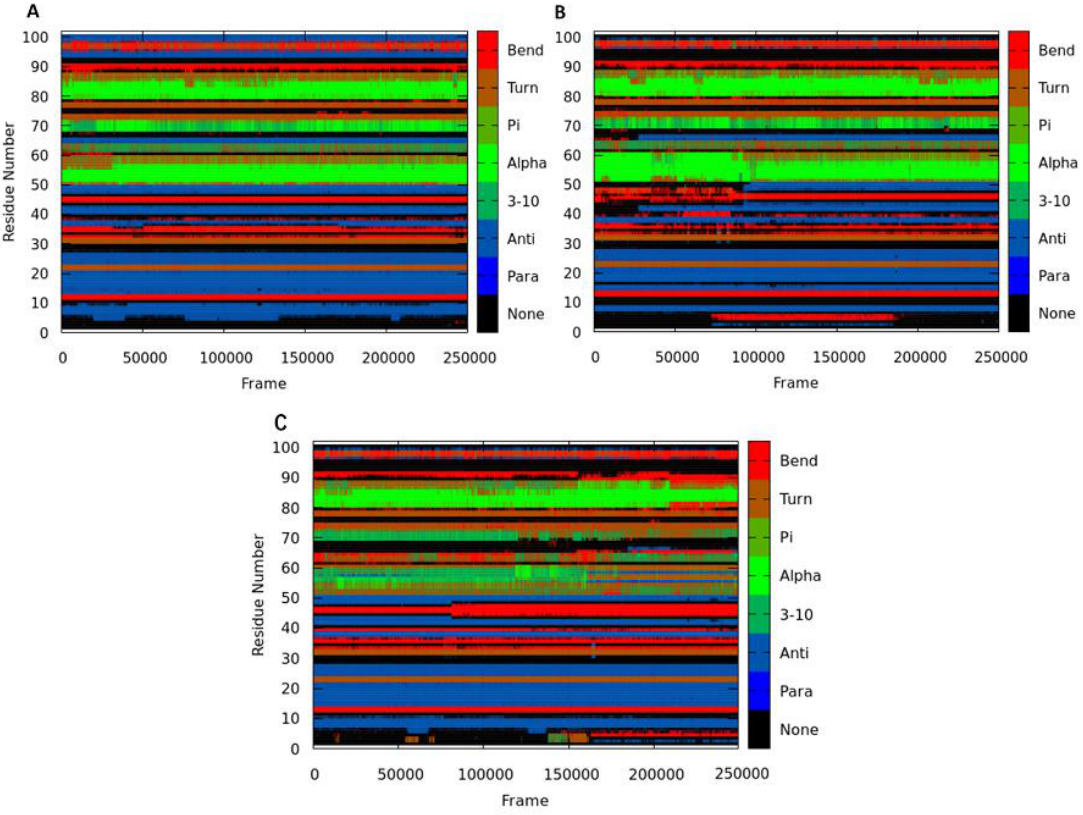
Figure 6. DSSP classification for the time evolution of the secondary structural elements for Apo ( A ), Cys-NBD ( B ), and Lys-NBD ( C ).